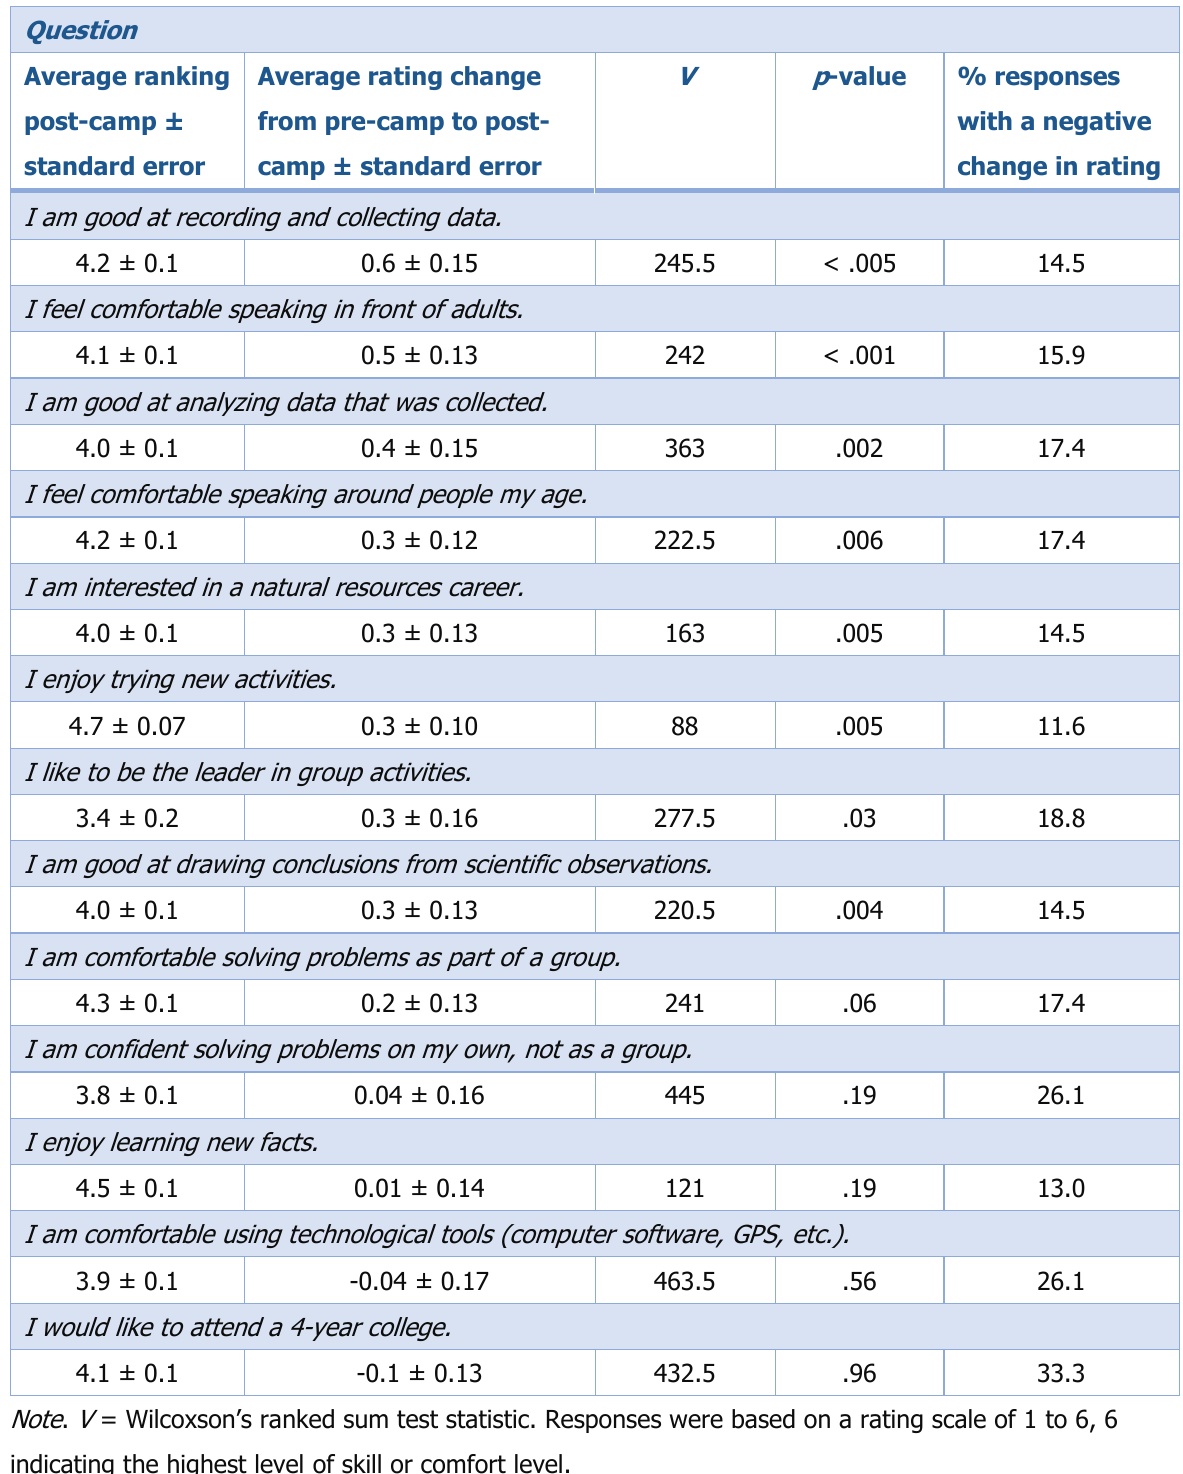
Table 1. Comparison of Participants’ Leadership Skills Survey Responses Before and After CCNRC attendance, 2014 -